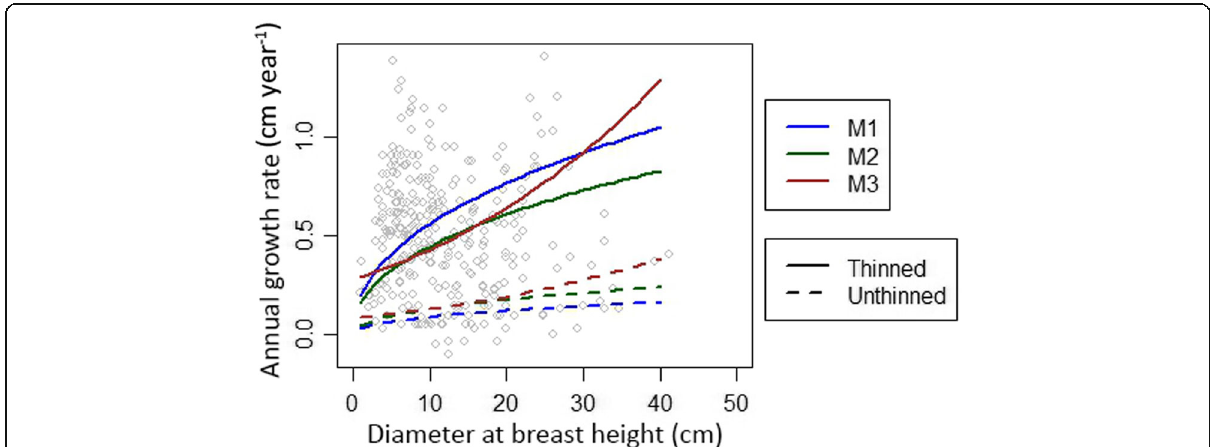
Fig. 3 Modelled growth trajectories of black beech in Woodside from 1- to 40-cm DBH. Observed annual growth rates plotted against the observed tree diameters at breast height ( grey points ). The curves indicate the predictions of the three models M1, M2 and M3 depending on the